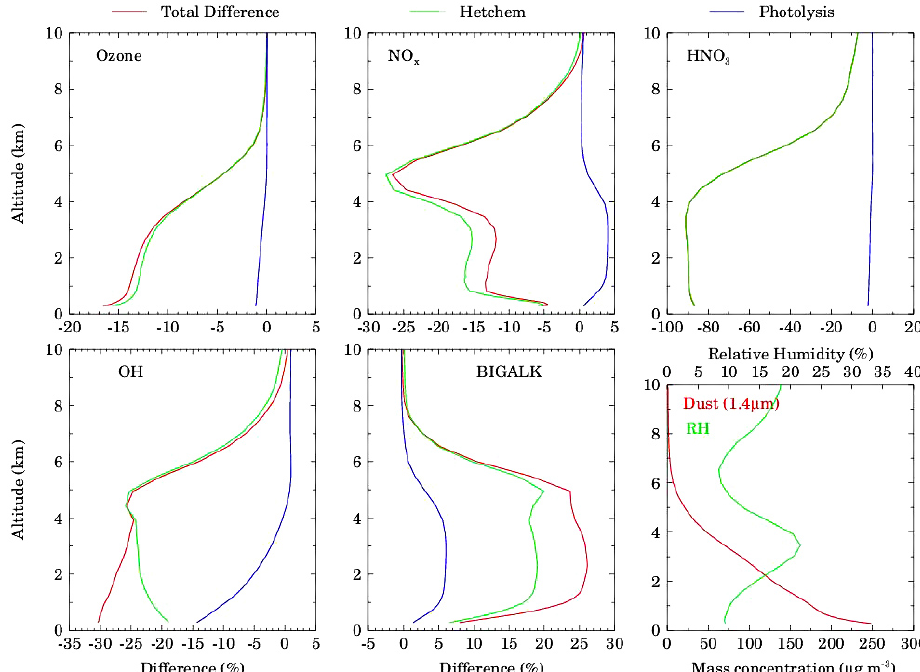
Figure 7. Vertical profiles of percentage total difference (red lines) in average O 3 , NO x , HNO 3 , OH and BIGALK between Dust_JH and No_Dust configuration over the geographical region (70–80 ◦ E, 25–30 ◦ N) of maximum dust influence. The contributions of heterogeneous chemistry (green lines) and photolysis (blue lines) to the total percentage difference are also shown. The vertical profiles of dust mass mixing ratios for particles of 1.4µm effective radius and relative humidity are also shown to help